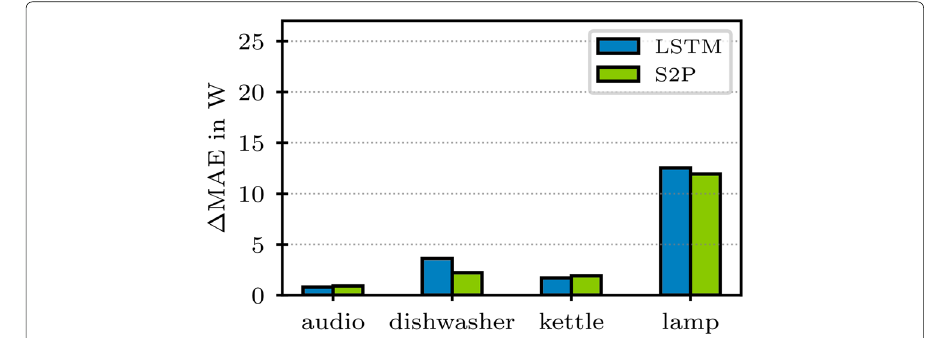
Fig. 3 Performance gap with regard to MAE for ECO house 2